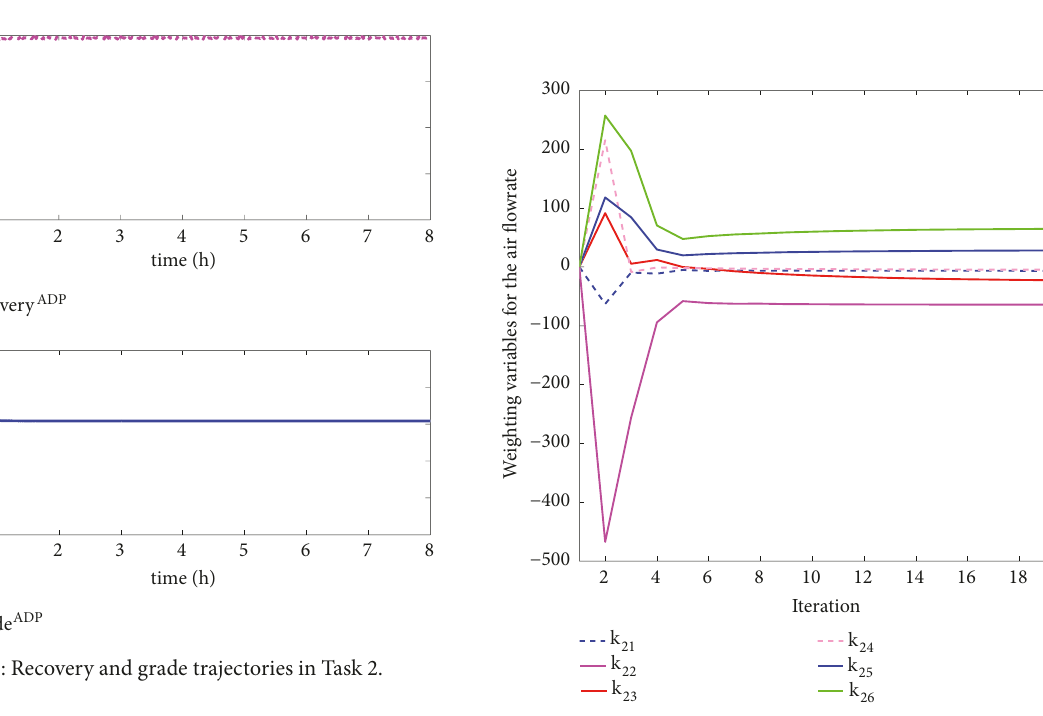
Figure 24: Iteration of the weighting variables for tailing flow rate in Task 2.